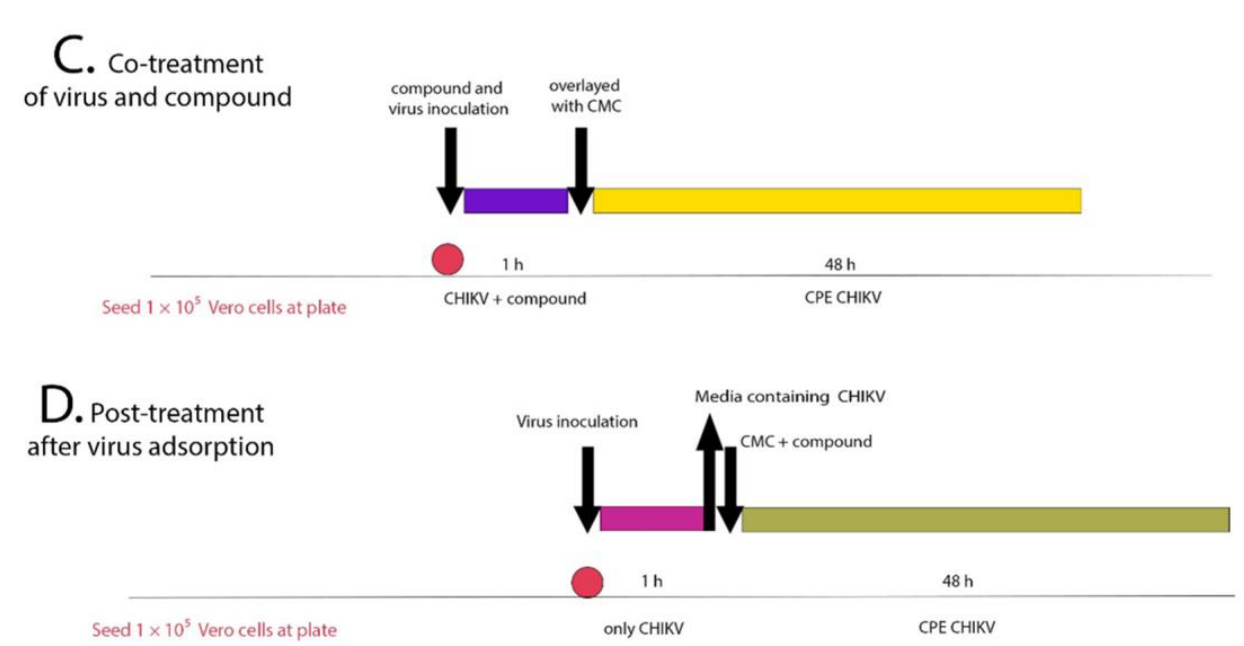
Figure 3. Schematic of antiviral assay at different stages of virus infection. ( A ) Virucidal assay that consists in pre-treatment of virus with compounds followed by inoculation of the treated virus to the cells; ( B ) pre-treatment assay: addition of the compounds at 2 h prior to virus infection; ( C ) co-treatment assay: virus incubated with the compounds at 37 ◦ C; ( D ) post-treatment assay: addition of the compounds at 1 h post-viral infection; CPE—cytopathic effect, CMC—carboxymethyl cellulose (the colors were used to differentiate each step of inoculation, there are no specific color mean- ings). Table 2. Inhibition efficacy (EC 50 ) of hops compounds in Vero cell lineages.